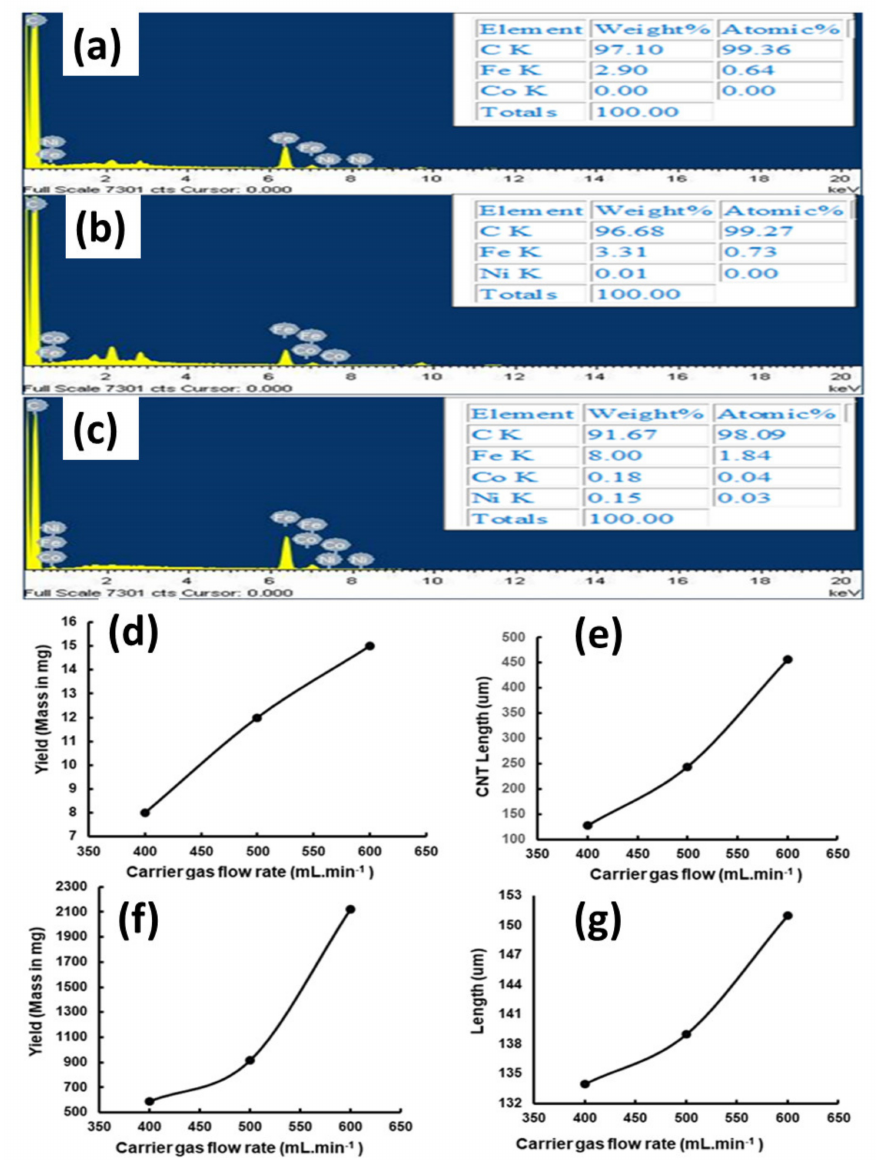
Figure 3. Elemental composition and yield of MWCNTs. Fe-Co ( a ), Fe-Ni ( b ) and Fe-Co-Ni ( c ). CNT yield on silicon wafer ( d ), CNT length on silicon wafer ( e ), CNT yield from quartz tube walls ( f ) and CNT length from quartz tube walls ( g